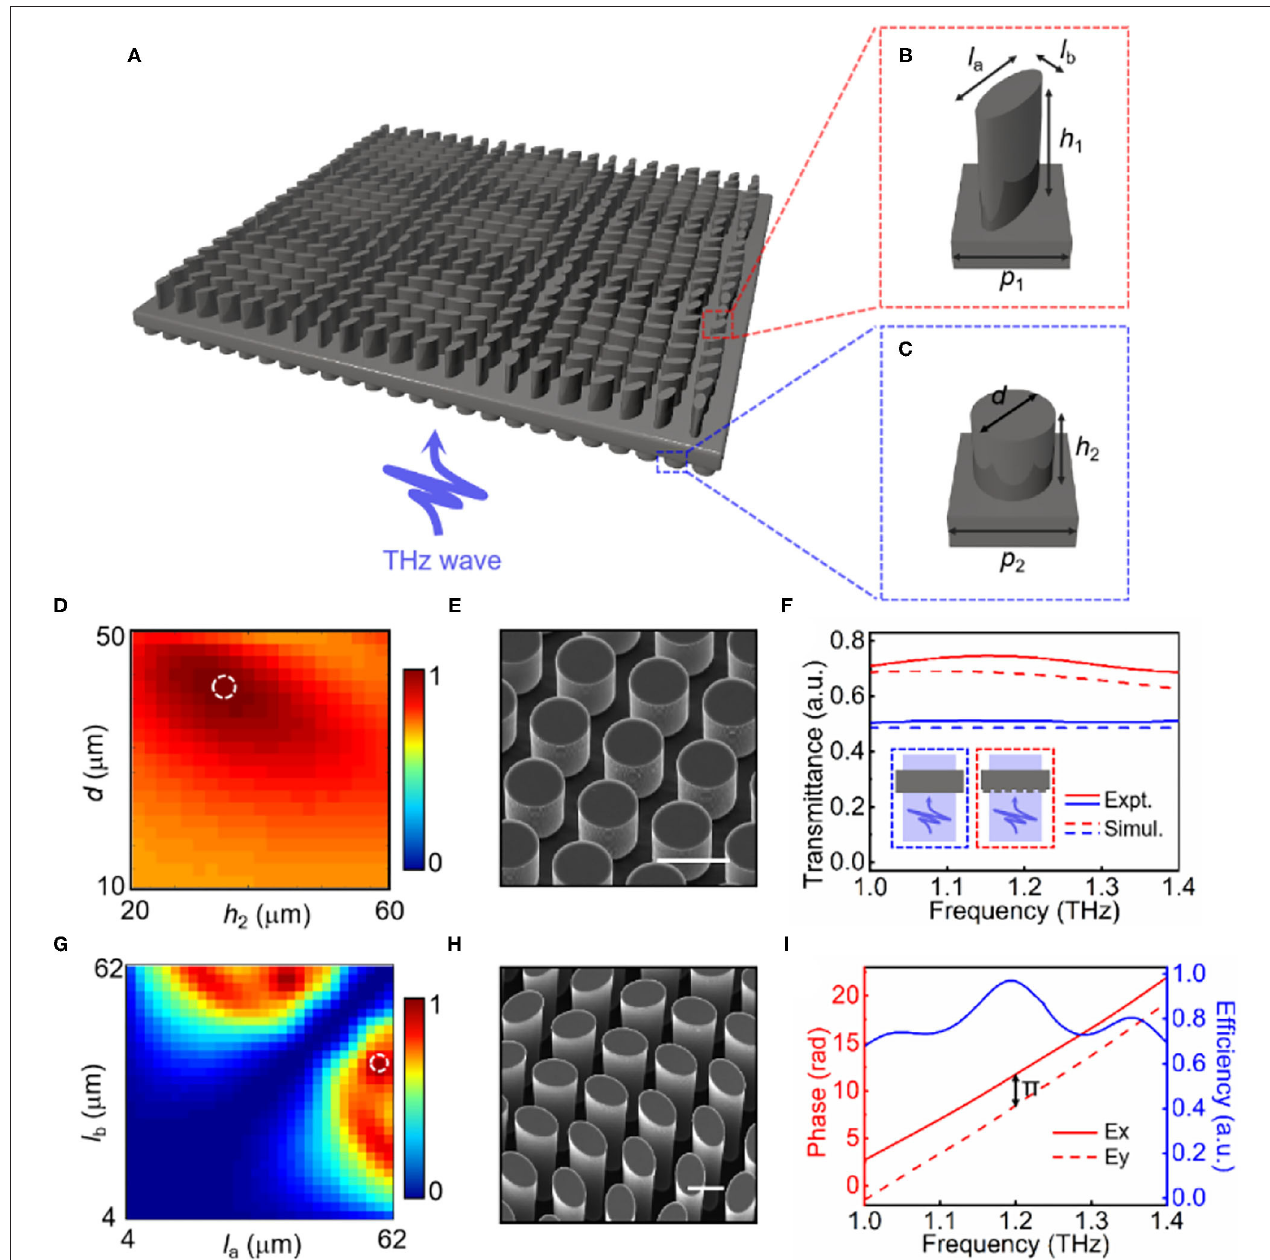
FIGURE 1 | Geometric designs and THz properties of the antireflection-layer-integrated metasurface. Schematic illustrations of (A) metasurface, (B) elliptical, and (C) circular silicon pillars, respectively. (D) Dependency of transmittance on d and h 2 at 1.20 THz. (E) SEM image of circular silicon pillars. (F) Frequency dependent transmittances of metasurfaces with (red) and without (blue) the antireflection layer. The insets show the corresponding metasurfaces. (G) Dependency of circular polarization conversion ratio on l a and l b at 1.20 THz. (H) SEM image of elliptical silicon pillars. (I) Frequency dependent resonant phase of the pillar with l a = 60 µ m and l b = 40 µ m under x - (red solid) and y - (red dot) incident polarizations and corresponding circular polarization conversion ratio (blue solid). All scale bars indicate 50 µ m.